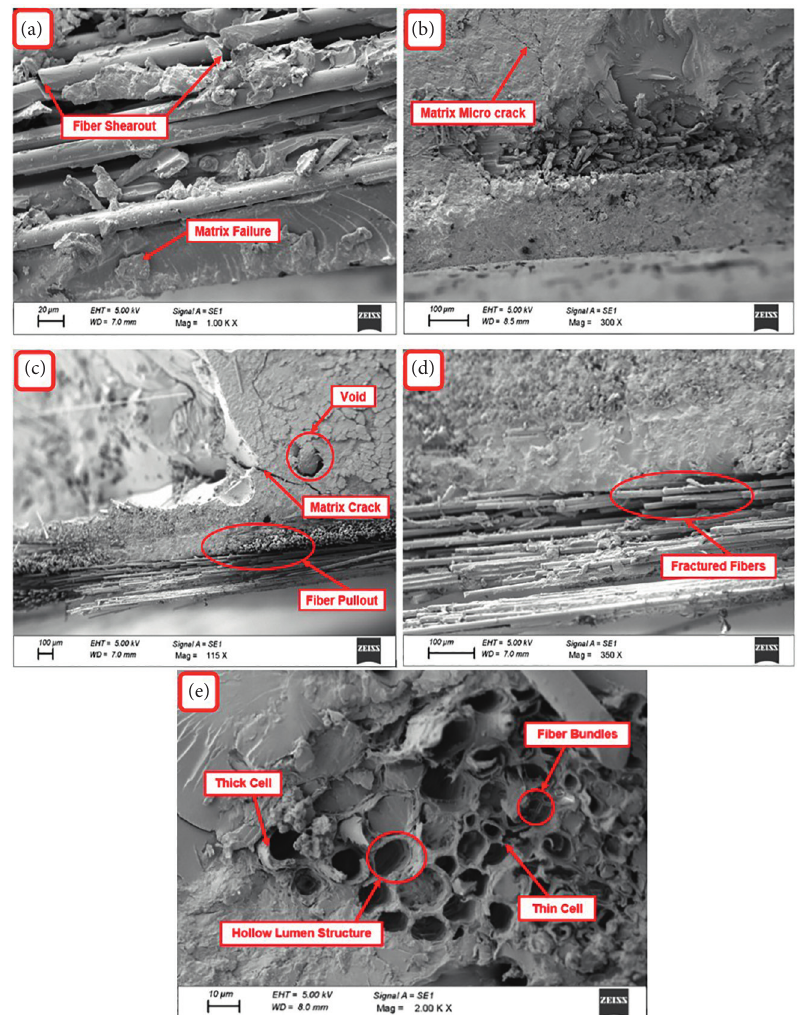
Figure 4: SEM micrographs of (a) tensile test of 5% NaOH-treated composites, (b) matrix microcrack, (c) fiber pull-out and void formation in the impact test specimen, (d) fractured surface of impact test specimen, and (e) hollow structure of natural hybrid fiber composites